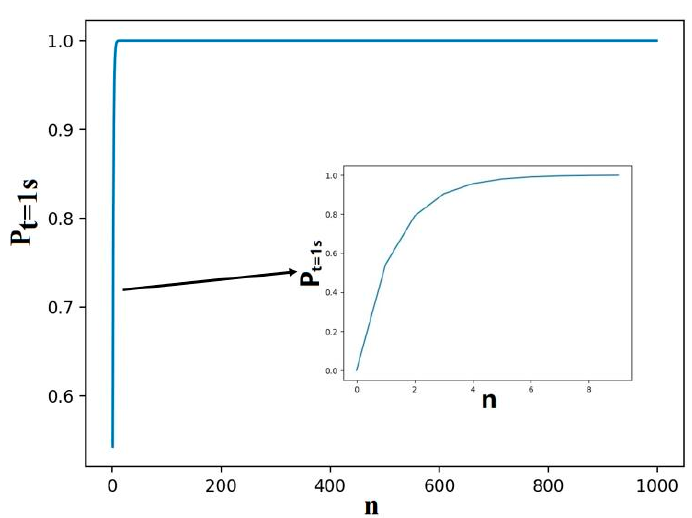
Figure 3. The relationship between the communication probability and the number of transmissions in 1 s.